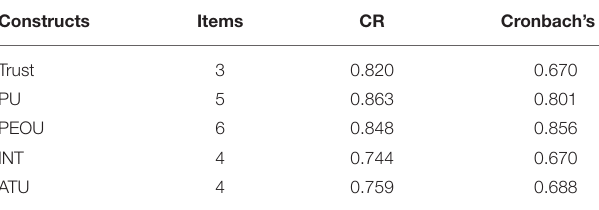
TABLE 3 | The CR and Cronbach’s α for constructs.